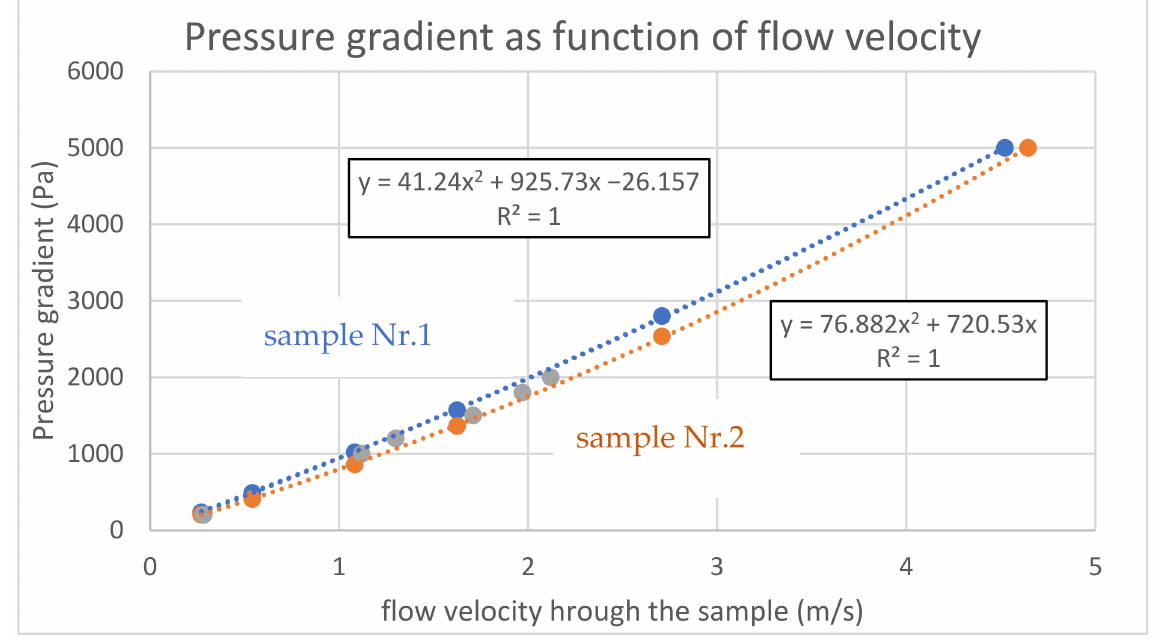
Figure 12. Air permeability up to 5000